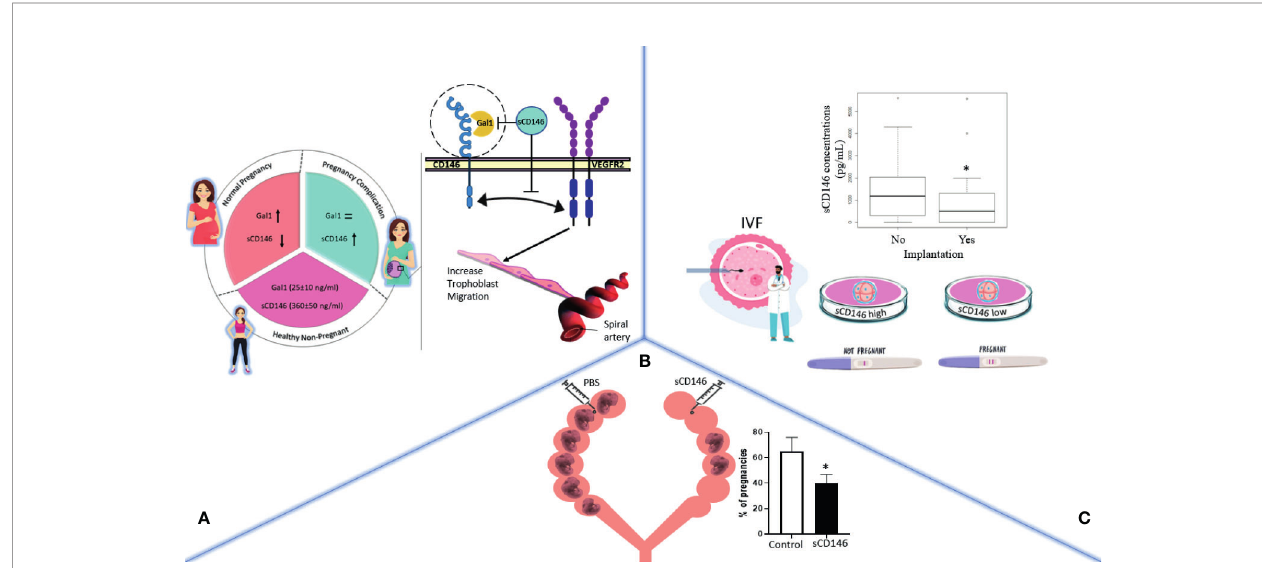
FIGURE 2 | The general effects of CD146/sCD146 in obstetrics are summarized in three illustrations. (A) In pregnancy, sCD146 and galectin 1 (Gal1) plasma concentration varies throughout the different stages of pregnancy. In case of pregnancy complications, sCD146 concentration surges, which in turn hinders Gal1/ membrane CD146 interaction, mutually known to activate trophoblasts migration toward the spiral arteries. (B) In implantation, sCD146 injection into female pregnant rats signi fi cantly decreases the number of embryos per litter. (C) In IVF, in vitro fertilized eggs producing high concentrations of sCD146 into their culture media fail implantation when transferred into the uterus, a boxplot of sCD146 concentrations between implanted (Yes, n = 37) and non-implanted embryos (No, n = 185) ( p = 0.024) is shown. *p <